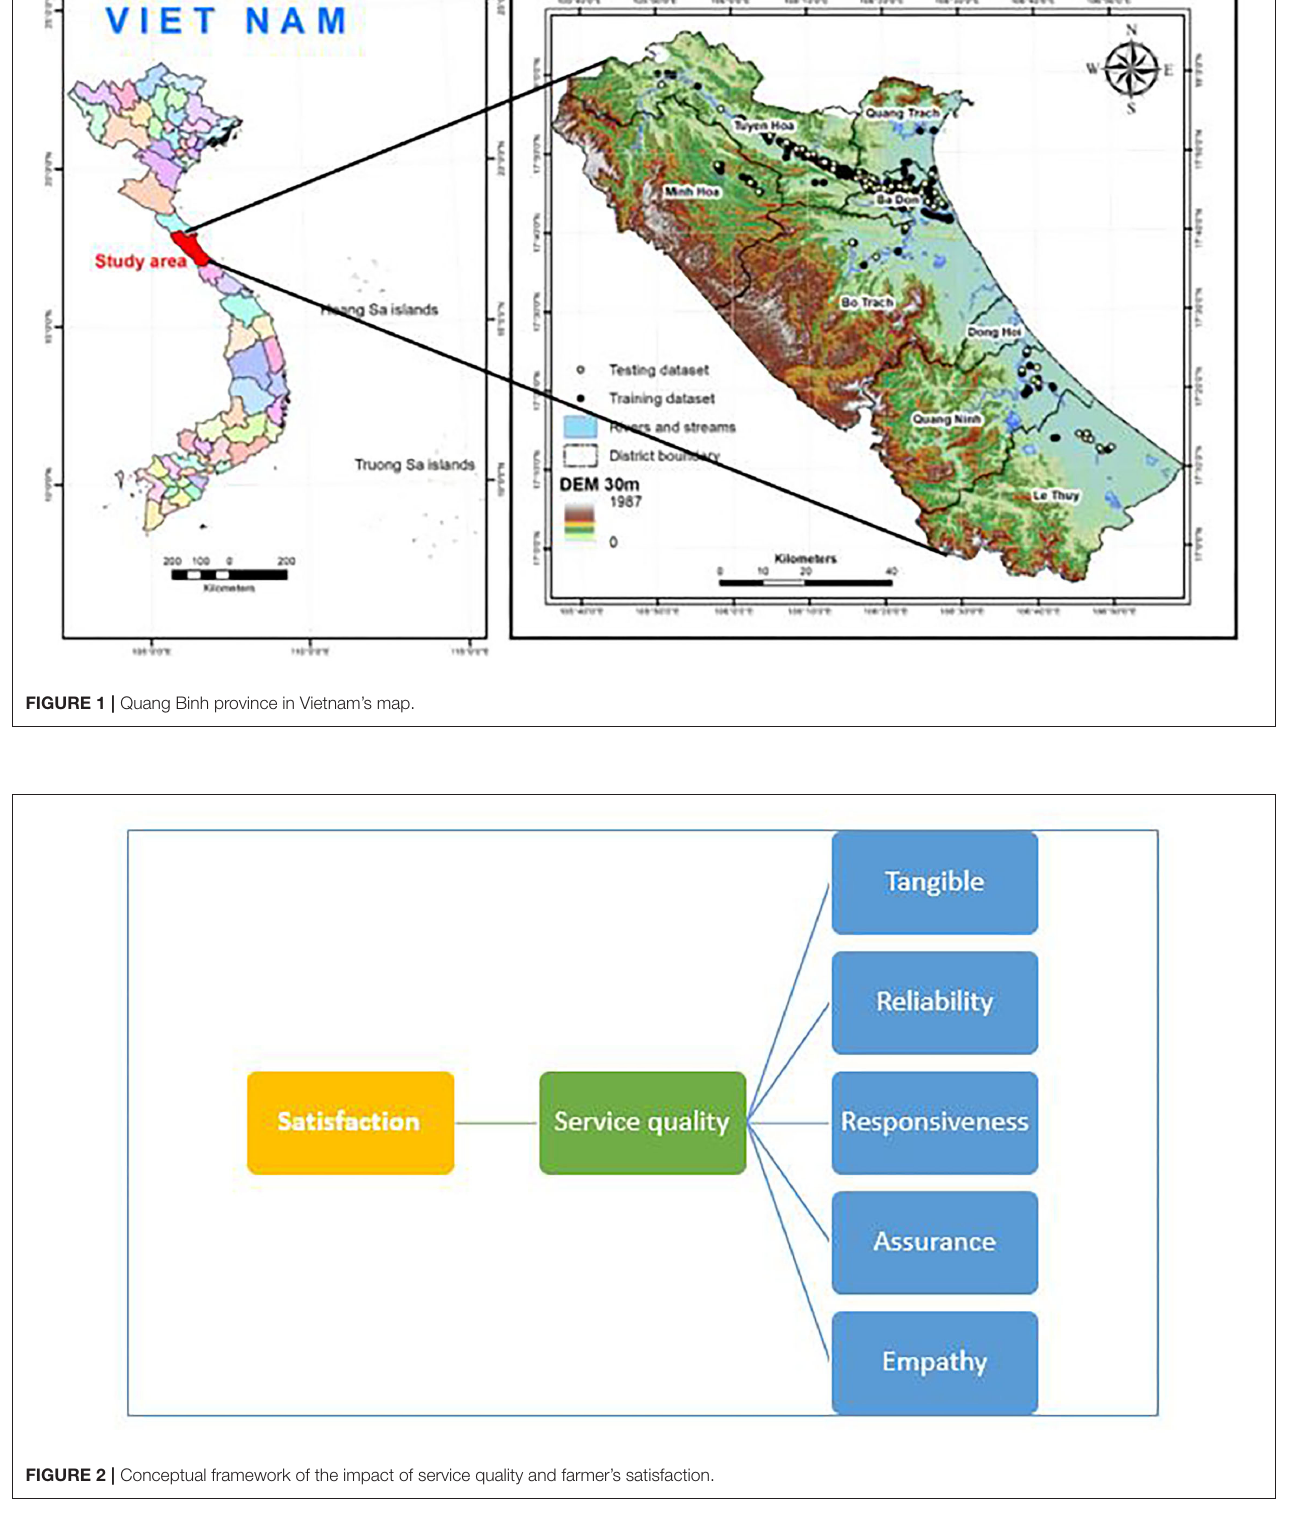
Frontiers in Sustainable Food Systems |